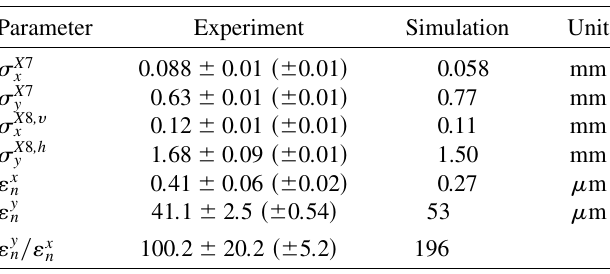
TABLE III. Measured and simulated flat-beam parameters for (cid:6) 0 : 97 mm . Both systematic and statistical (in brackets) (cid:2) c error bars are included.